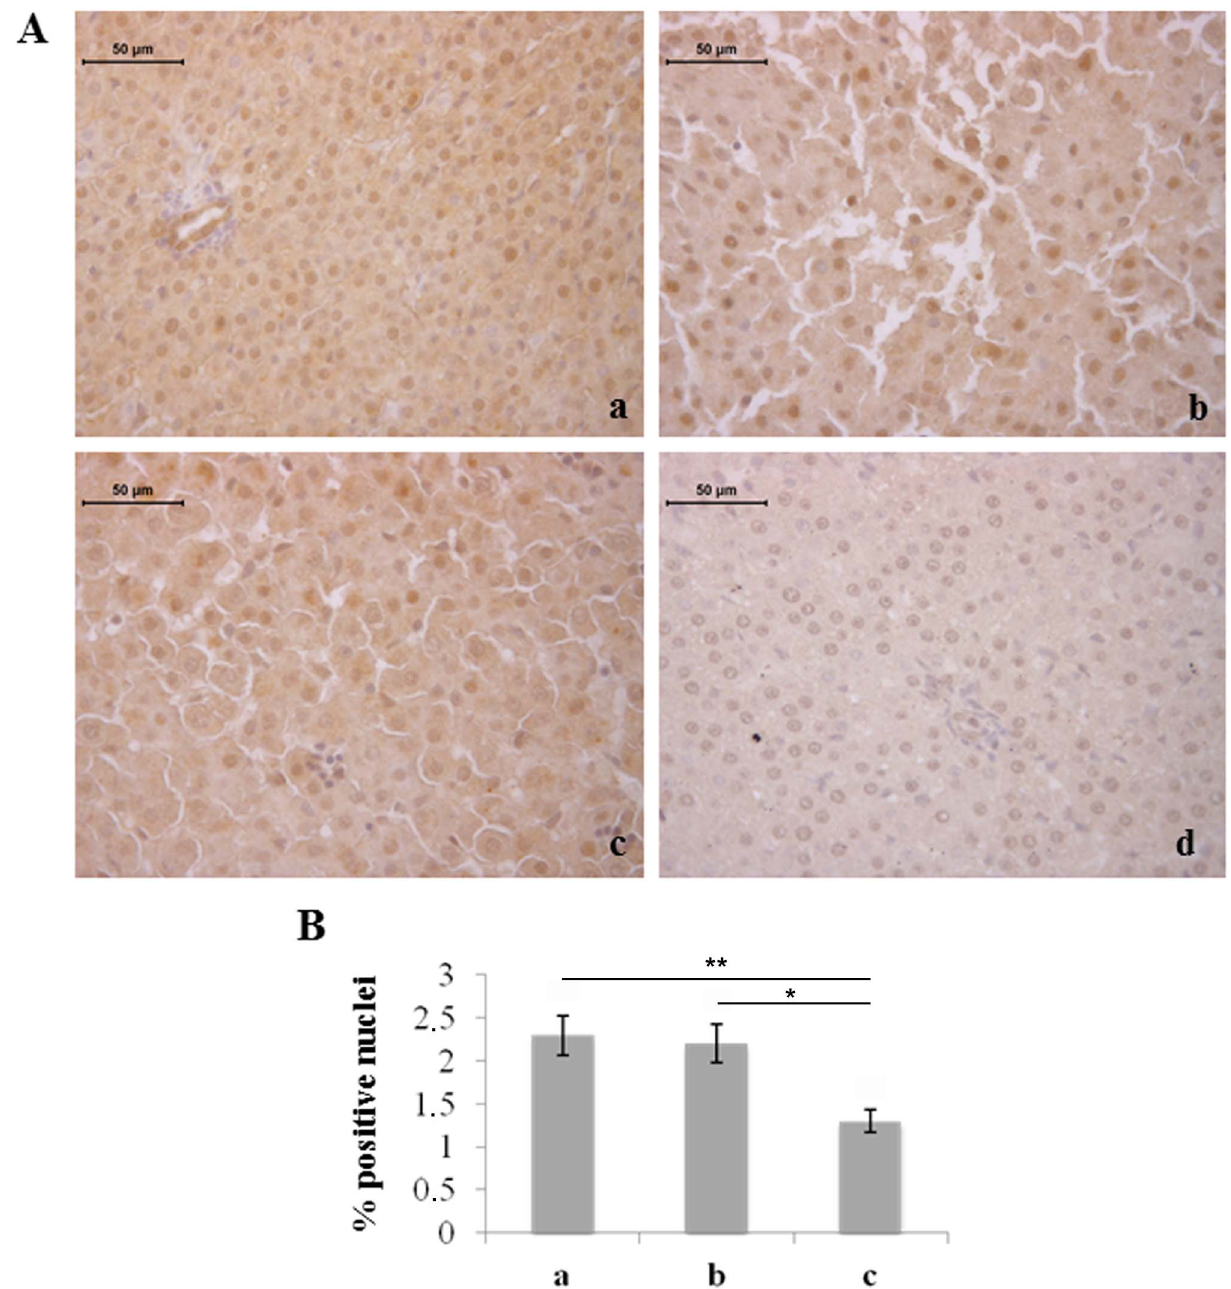
Figure 5. Severe hyperoxia decreases the number of hepatocytes immunostained for VEGF. A) Immunohistochemical detection of VEGF expression in neonatal rat livers exposed to moderate and severe hyperoxia. a) ambient air; b) 60% hyperoxia; c) 95% hyperoxia; d) negative control; scale bar: 50 m m, magnification 40x. B) Graphic representation of the percentage of VEGF positive nuclei ( 6 SD); densitometric analysis determined by direct visual counting of ten fields for each of three slides per sample. *=p , 0.05; **=p , 0.01.